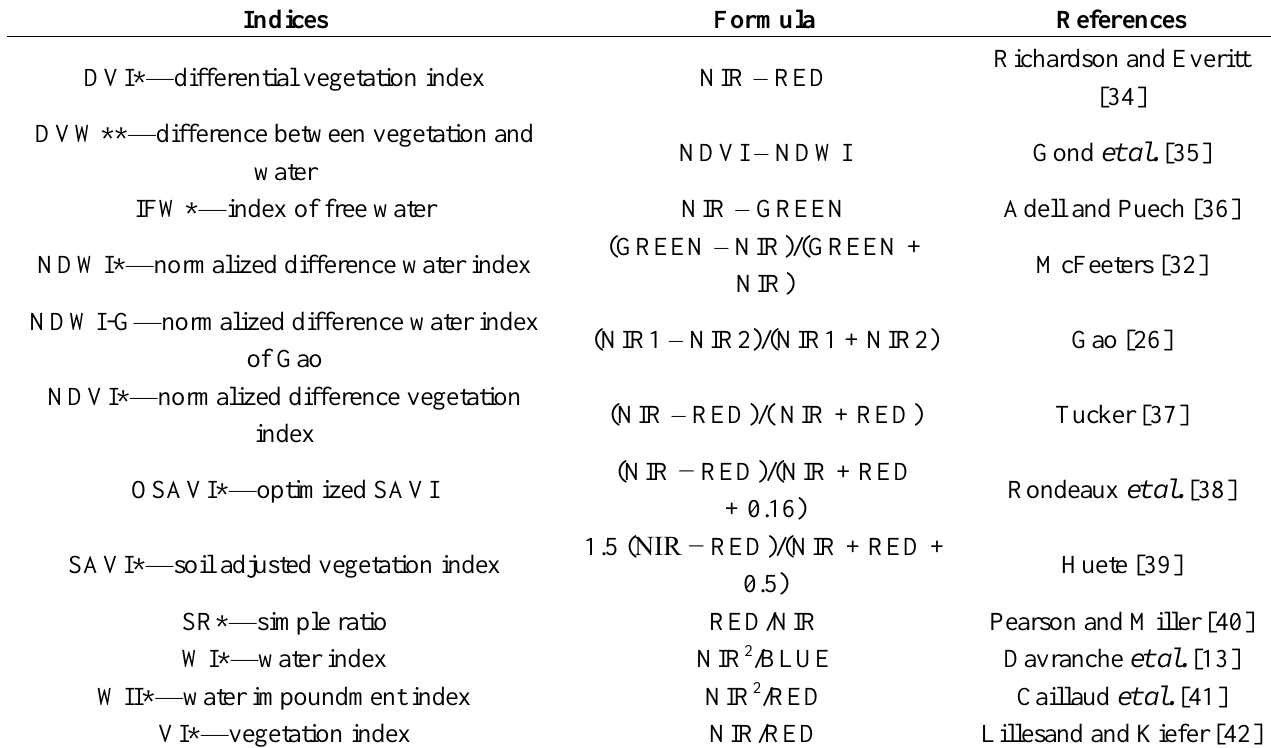
Table 2. List of multispectral indices derived from the spectral bands of the WorldView-2 image data, used for the decision tree classifications in this